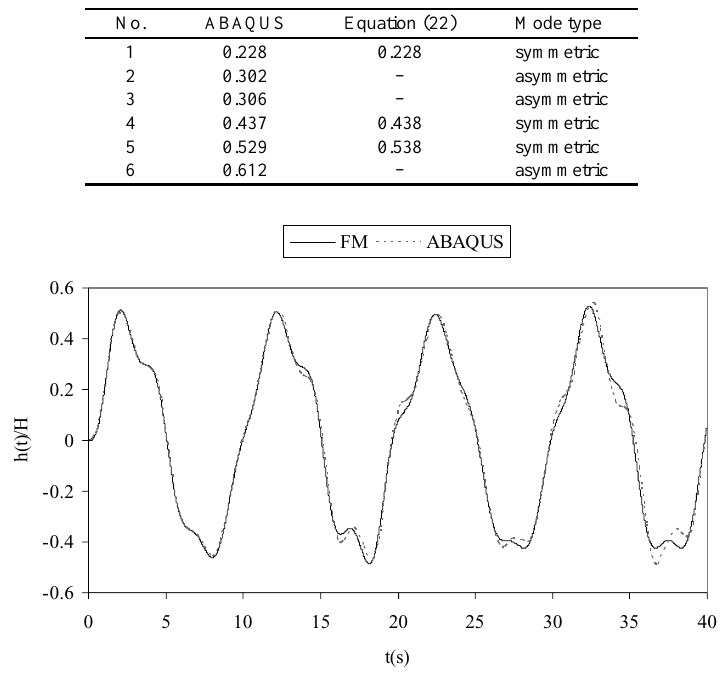
Fig. 4. Nonlinear dynamic response h ( t ) of a single-span cable ( f =0.1H z ,q 0 = 0.3 H / l ) .